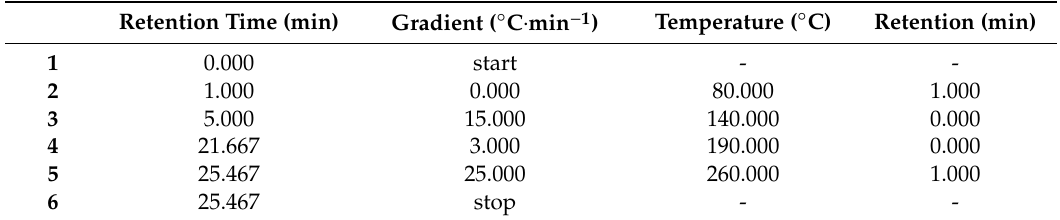
Table 3. Temperature program of GC